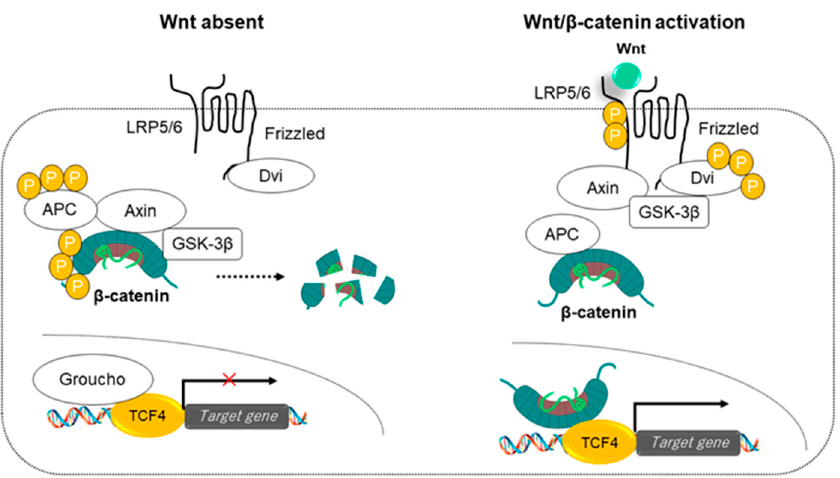
Figure 2. Canonical Wnt signaling pathway. ( Left panel ) When Wnt is not bound to the Frizzled/LRP coreceptor complex, GSK-3 β phosphorylates β -catenin. The phosphorylated β -catenin is rapidly destroyed by the proteasome. In the nucleus, the binding of Groucho to TCF inhibits the transcription of Wnt target genes. ( Right panel ) Receptor complexes bound to Wnt activate canonical signaling pathways; Wnts induce phosphorylation of LRP by GSK-3 β and stabilize β -catenin when Axin is recruited. In the nucleus, β -catenin displaces Groucho from TCF/LEF to promote the transcription of Wnt target genes.